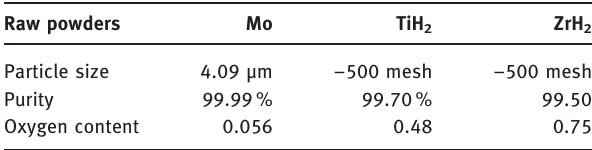
Table 1: The particle size, purity and oxygen content of the raw powders.